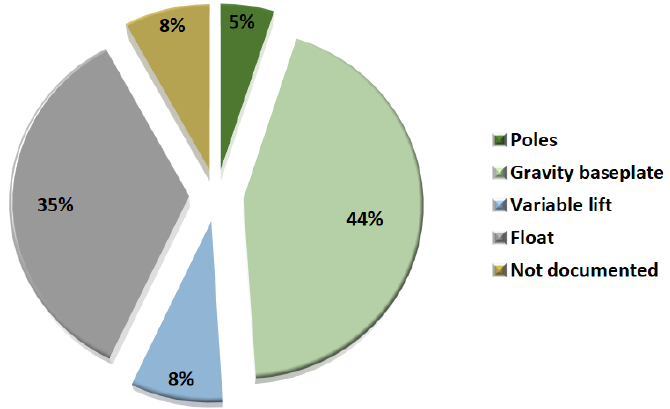
Figure 12. Type of hydrokinetic mounting, worldwide trend [19]. c (cid:13) Reproduced with permission from SEENEOH,